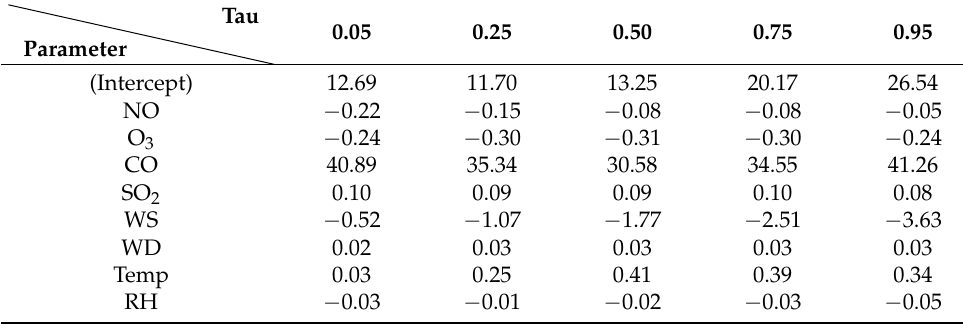
Figure 5. Outputs of the quantile regression model for analyzing O 3 concentrations (ppb) using several explanatory variables in Jeddah, Saudi Arabia, 2018-2019. The black dotted dashed lines show coefficients at different quantiles of the covariates and the shaded areas show the confidence intervals. The red solid lines show the coefficients of ordinary multiple linear regression model, whereas the red dotted lines show the confidence intervals of the mean coefficients. x -axes show quantiles of the dependent variable and y -axes show the regression coefficients for specified independent variables. Table 4. Model coefficients at different quantiles (tau) of NO 2